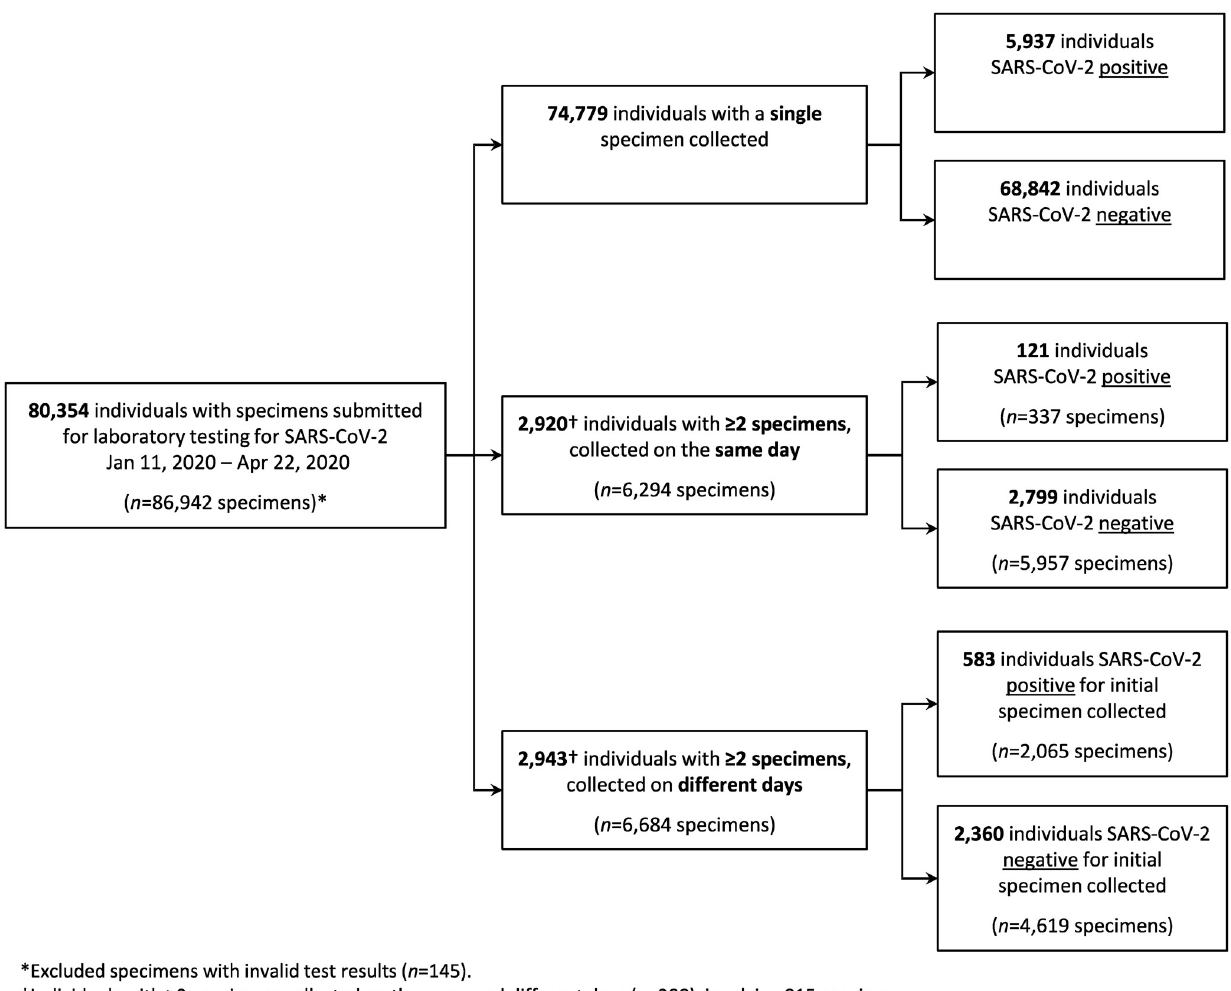
Fig 1. SARS-CoV-2 molecular-based testing results for individuals with specimens submitted to Public Health Ontario, January 11, 2020 –April 22, 2020. Individuals were considered positive if any specimen had rRT-PCR detection of the envelope (E) gene, RNA-dependent RNA polymerase (RdRp) gene, ORF1ab and/or end-point PCR + Sanger sequencing of the RdRp gene. Indeterminate results were counted as positive for the purpose of this analysis ( n = 19).